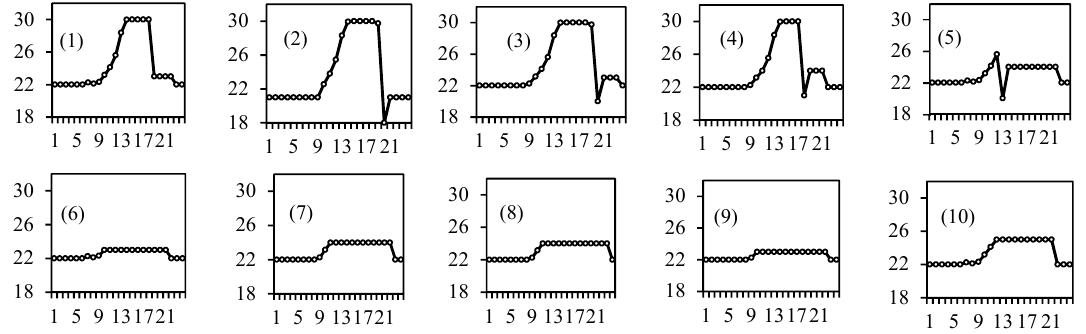
Figure 12. Temperature control of each household during summer season in building ( X -axis: interval